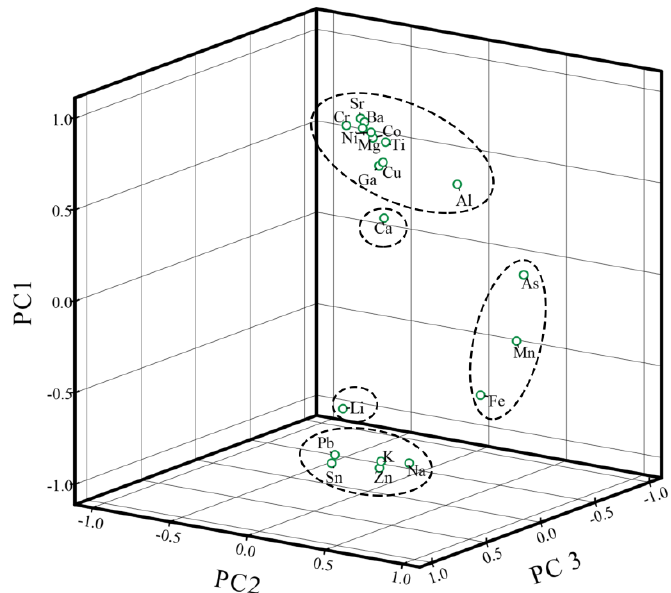
Figure 5. Principal component analysis of 20 metals in volcanic soil and volcanic ash.